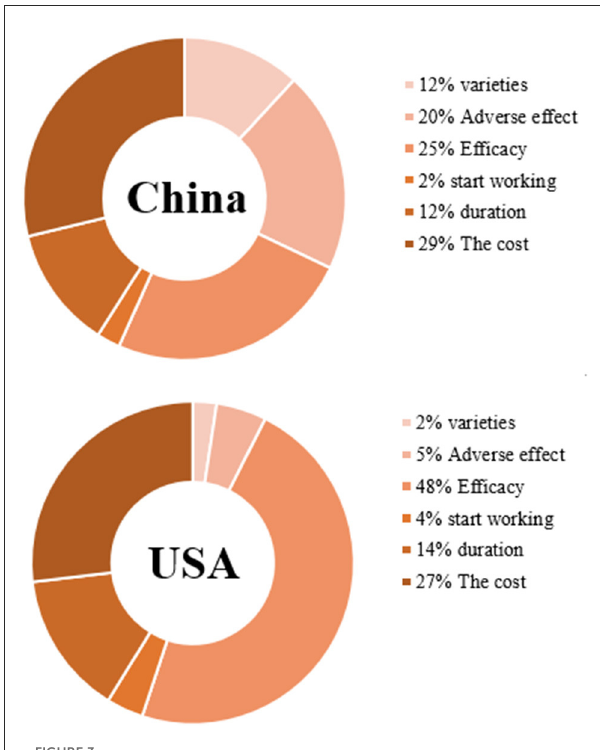
FIGURE3 Attribute relative importance in a conditional logit model.